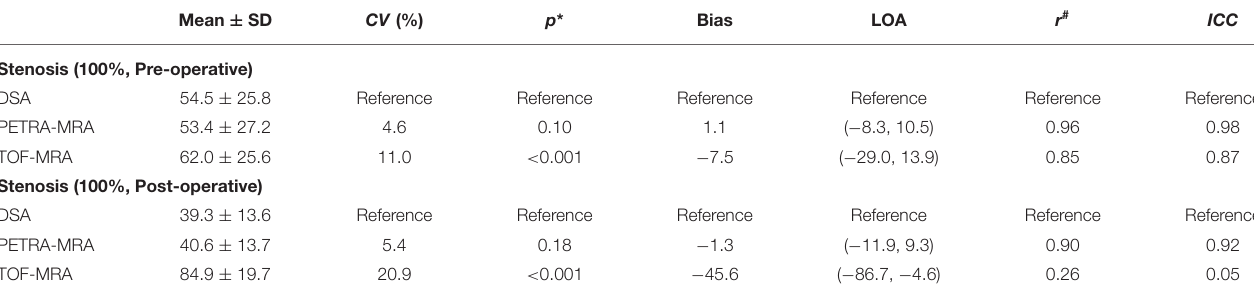
TABLE 1 | Comparison of PETRA-MRA/TOF-MRA and DSA in measurements of stenosis. Mean ± SD CV (%) p